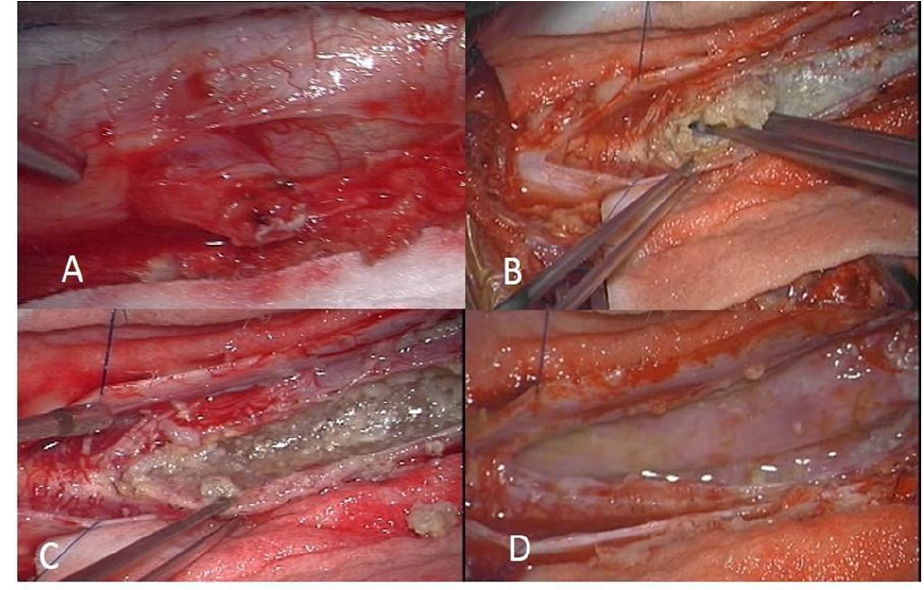
Figure 1 : Surgical pictures showing the myelotomy and the resection of the dermoid tumor. After the resection the final aspect of spinal cord without